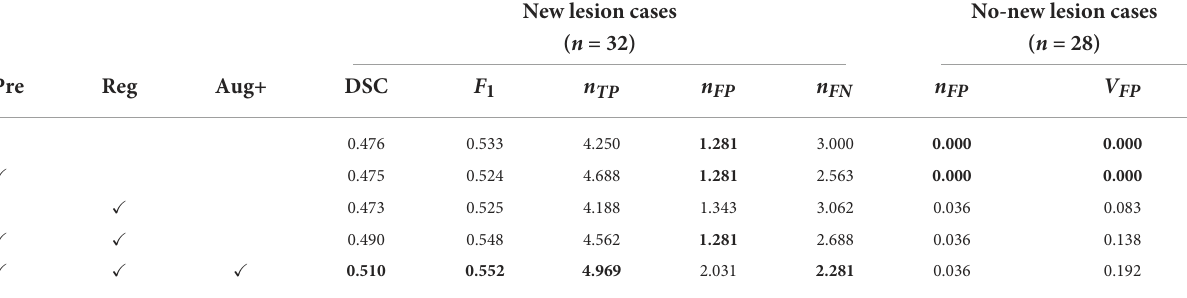
TABLE 3 Results for the ablation study, presenting DSC and F 1 scores, the number of false positive lesions n FP , the number of true positive lesions n TP , the number of false positive lesions n FP , the number of false negative lesions n FN , and volume of false positive lesions n FP (unit: mm 3 ), averaged across